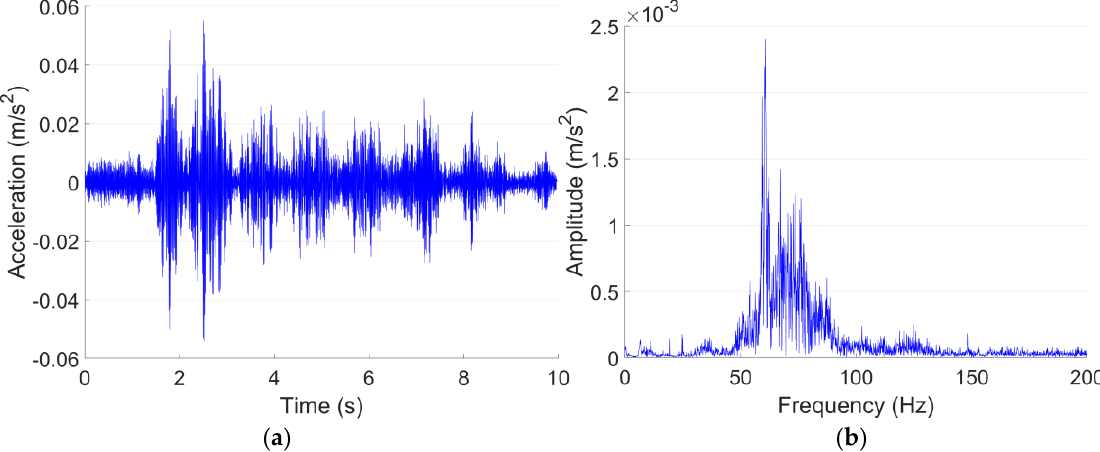
12 of 21 Figure 12. Cross-section diagram of mutual position relationship between the shopping center and Metro Line A. The ground vibration of the shopping center is validated using the vibration meas-